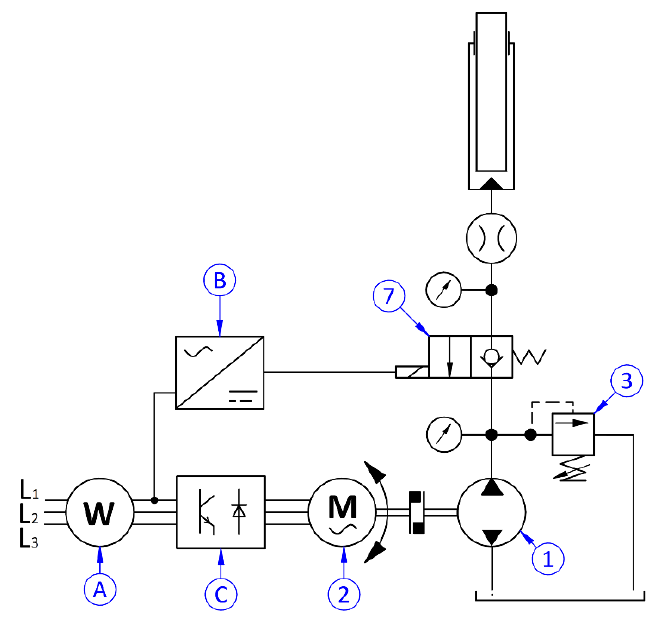
Figure 2. Hydraulic scheme of electro-hydraulic drive (EHD).